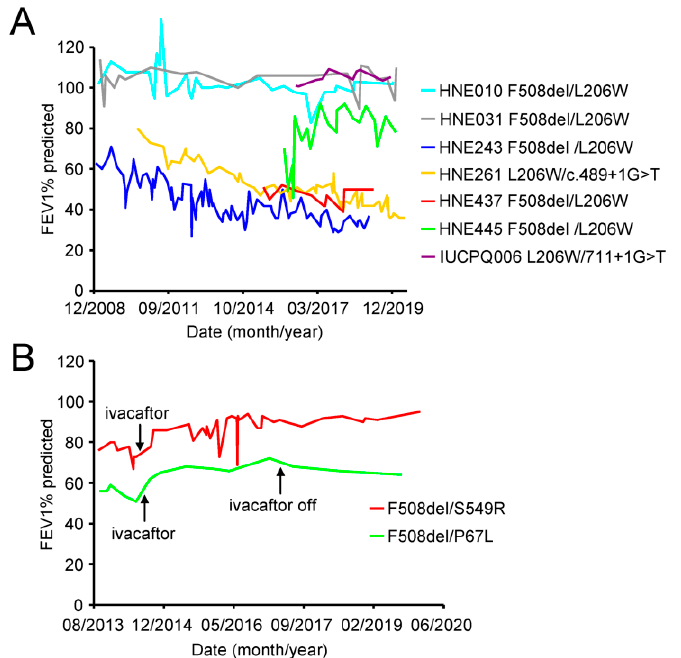
Figure 3. Longitudinal development of the FEV1% predicted in patients carrying one allele of the P67L-, L206W- or S549R-CFTR mutation. ( A ) Development of the FEV1% predicted over time for patients carrying the L206W mutation on one allele. ( B ) Development of the FEV1% predicted over time for patients carrying one allele of the P67L or S549R mutation.